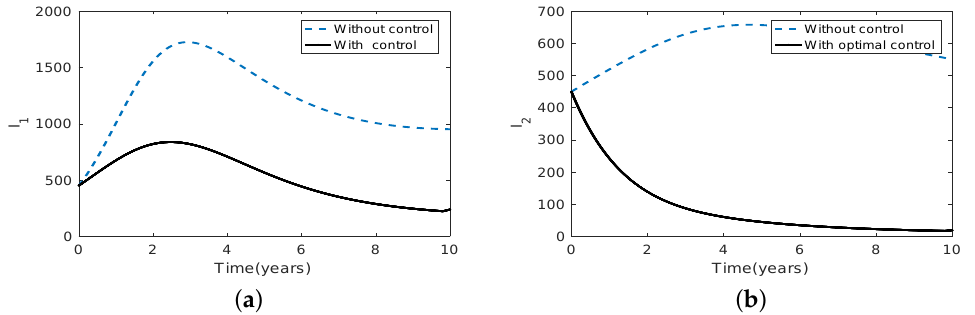
Figure 6. Simulation results of the proposed brucellosis model demonstrating the disease dynamics for scenario 2 under weak symmetric coupling ( a ) the numbers of infected animals in patch 1 ( b ) the numbers of infected animals in patch 2. In all the figures the dotted blue and solid black curves represent the infected population, without and with control, respectively.